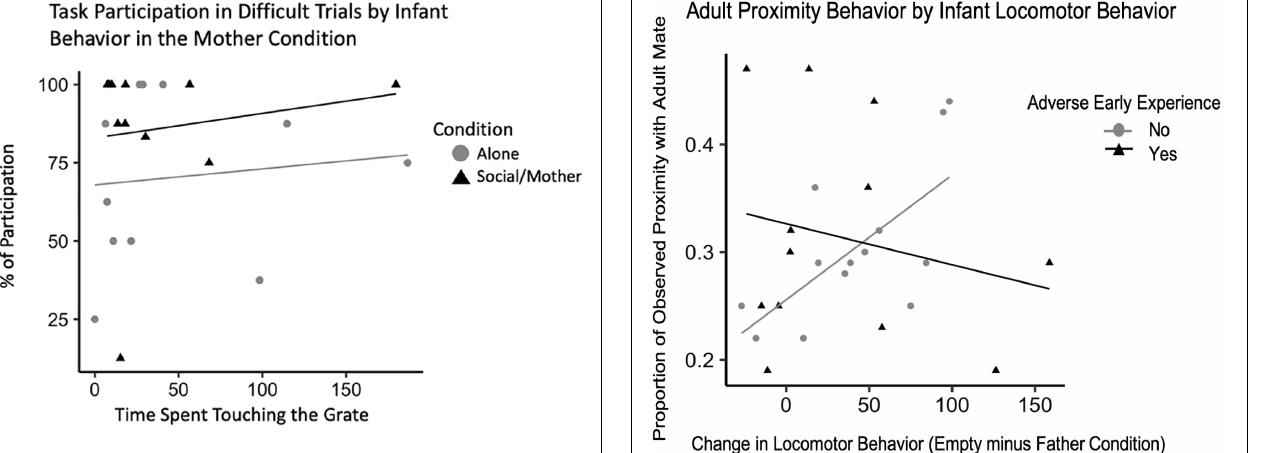
FIGURE 7 | Difference scores for infant locomotor behavior ( N = 25) plotted against the proportion of observations they were observed in proximity with their mate as adults with lines of best fit.